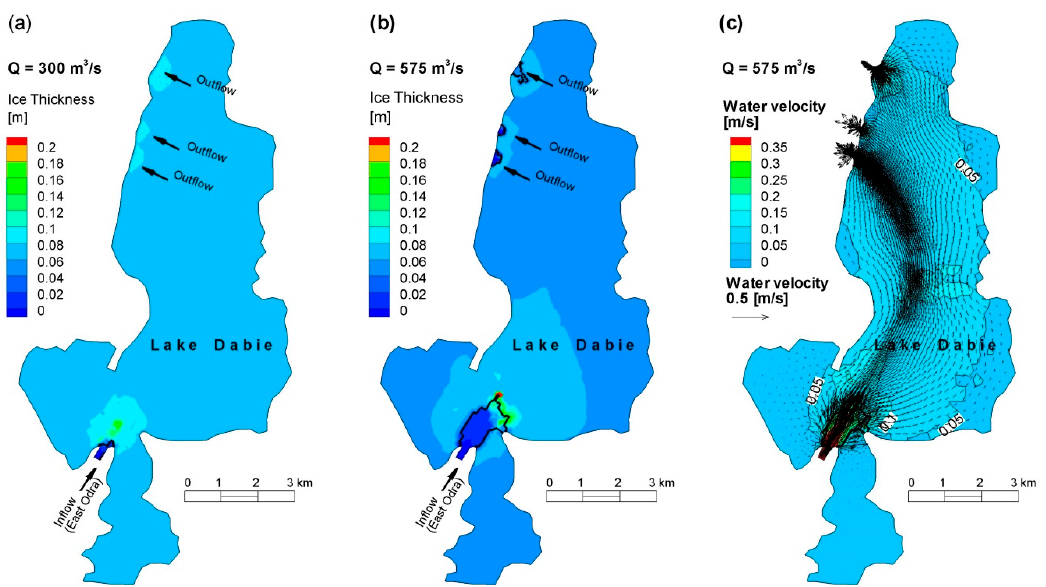
Figure 3. Ice cover extent (black line) and thickness for air temperature data from February–March 2018, and variable water discharge: ( a ) low water discharge Q = 300 m 3 /s; ( b ) average water discharge Q = 575 m 3 /s; ( c ) water velocity distribution in Lake D ą bie for average water discharge.